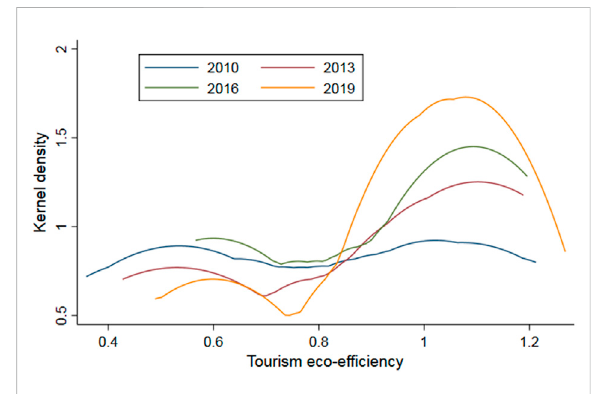
FIGURE 2 Kernel density analysis of tourism eco-ef fi